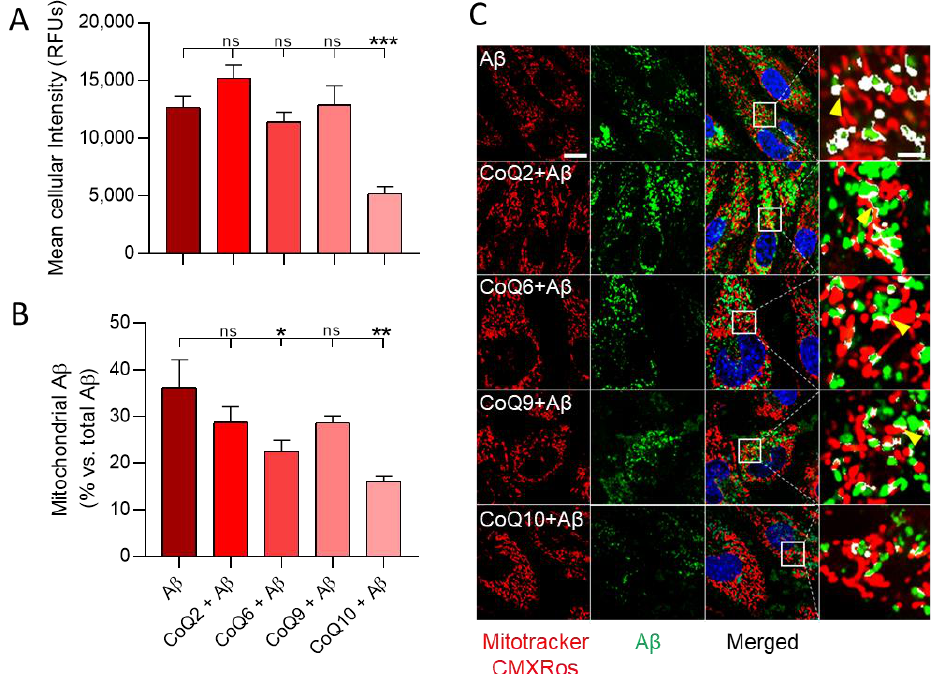
Figure 6. A β 25–35 internalization and mitochondrial colocalization in bEnd.3 cells exposed to A β 25–35 and different CoQs. bEnd.3 cells were pretreated with CoQ2, CoQ6, CoQ9, or CoQ10 for 24 h and then treated with A β 25–35 HyLite TM 488 for 24 h. ( A ) Internalized fluorescent A β 25–35 is expressed as RFUs. ( B ) Mitochondrial-fluorescent A β 25–35 was measured as the percentage of fluorescent A β 25–35 present into mitochondria compared to total internalized A β 25–35 . ( C ) Images show cells stained with Mitotracker CMXros (red) and A β 25–35 (green) and their colocalization. Detailed images show the colocalized areas in white (scale = 20 µ M/scale augmented = 5 µ M). Data are presented as the mean ± SEM. Dunnett’s multiple comparison test compared each A β 25–35 plus ubiquinone treatment with A β 25–35 . ns: not significant, * p < 0.05, ** p < 0.01, *** p < 0.001, ( n = 3).